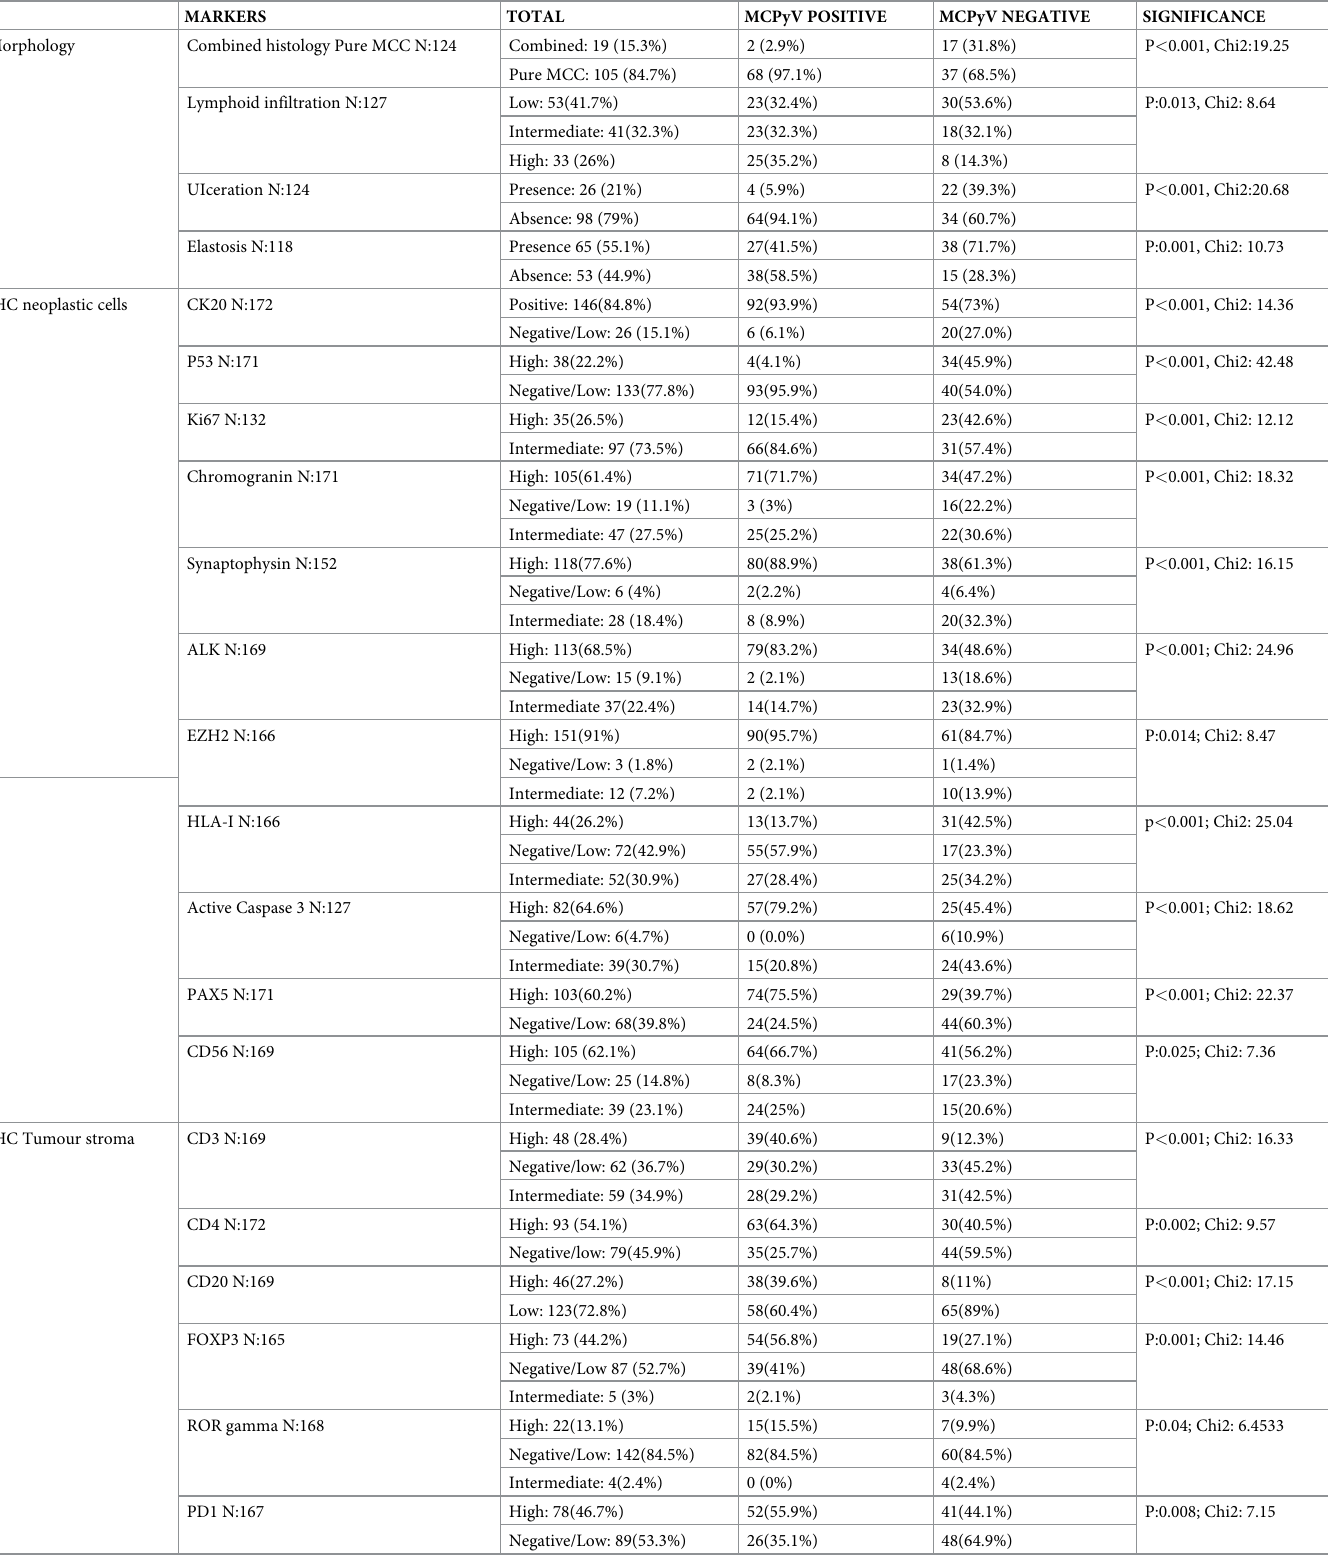
Table 6. Comparison between MCPyV-positive and negative cases. MARKERS MCPyV NEGATIVE